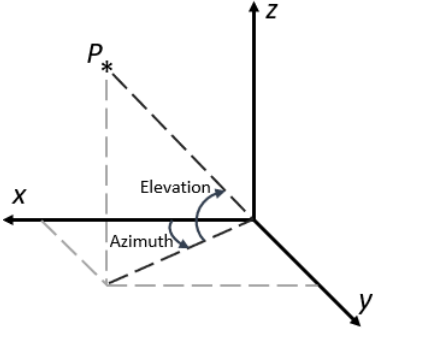
Figure 4. Azimuth and elevation angles